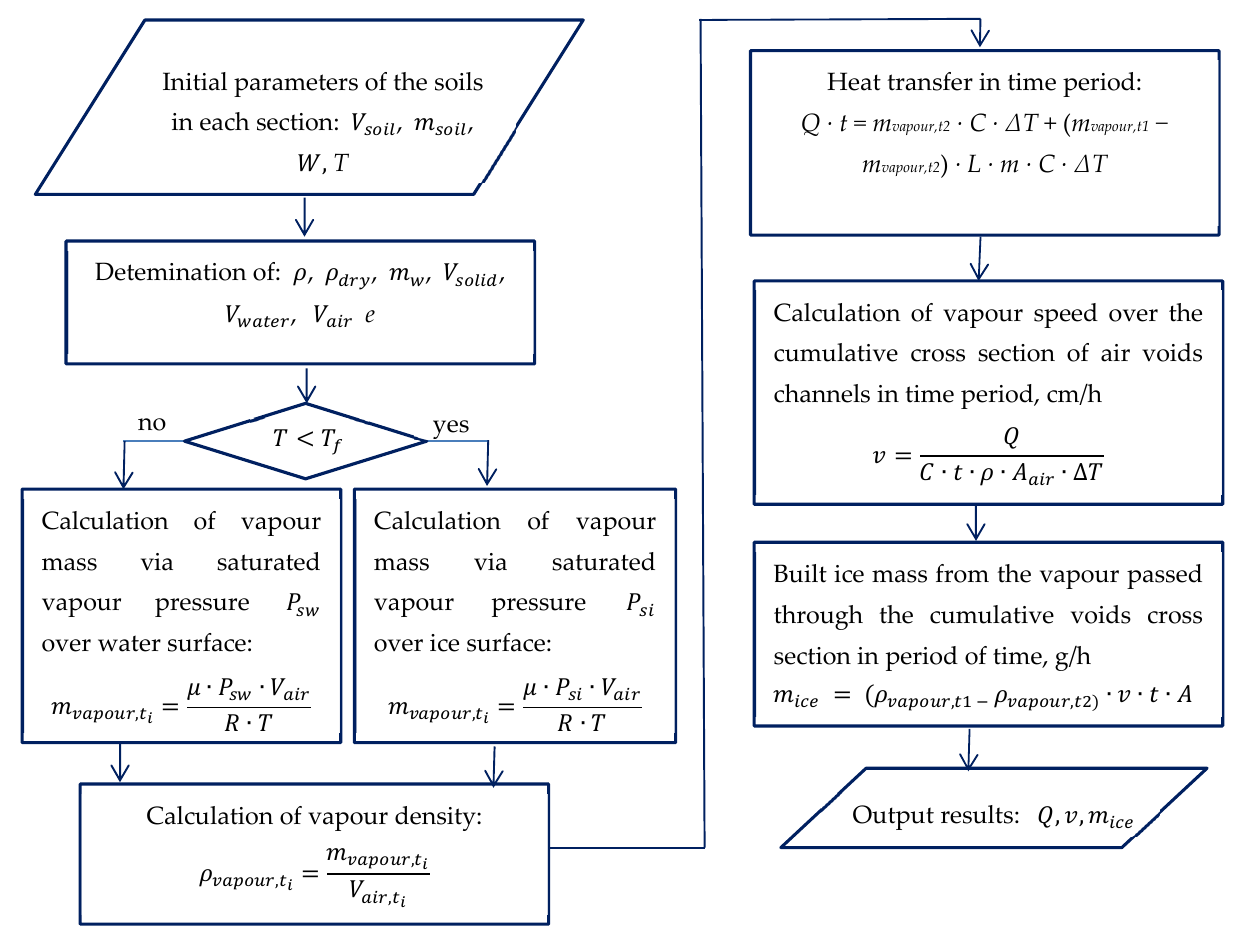
Figure 4. Algorithm for the vapour mass transfer calculation.